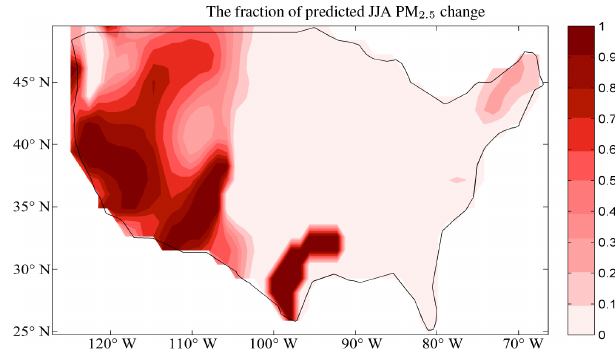
Figure 10. The fraction of predicted JJA PM 2 . 5 change using sim- ulated data fitted (current climate from the coupled model simu- lation, GCM2000, 2006–2025 mean; Fig. 9b divided by Fig. 9a) model accounts for the total JJA PM 2 . 5 change from simulations. The fraction that is less than zero is regarded as zero. Stippling indi- cates where R 2 is significant (at the 5% significance level) at model